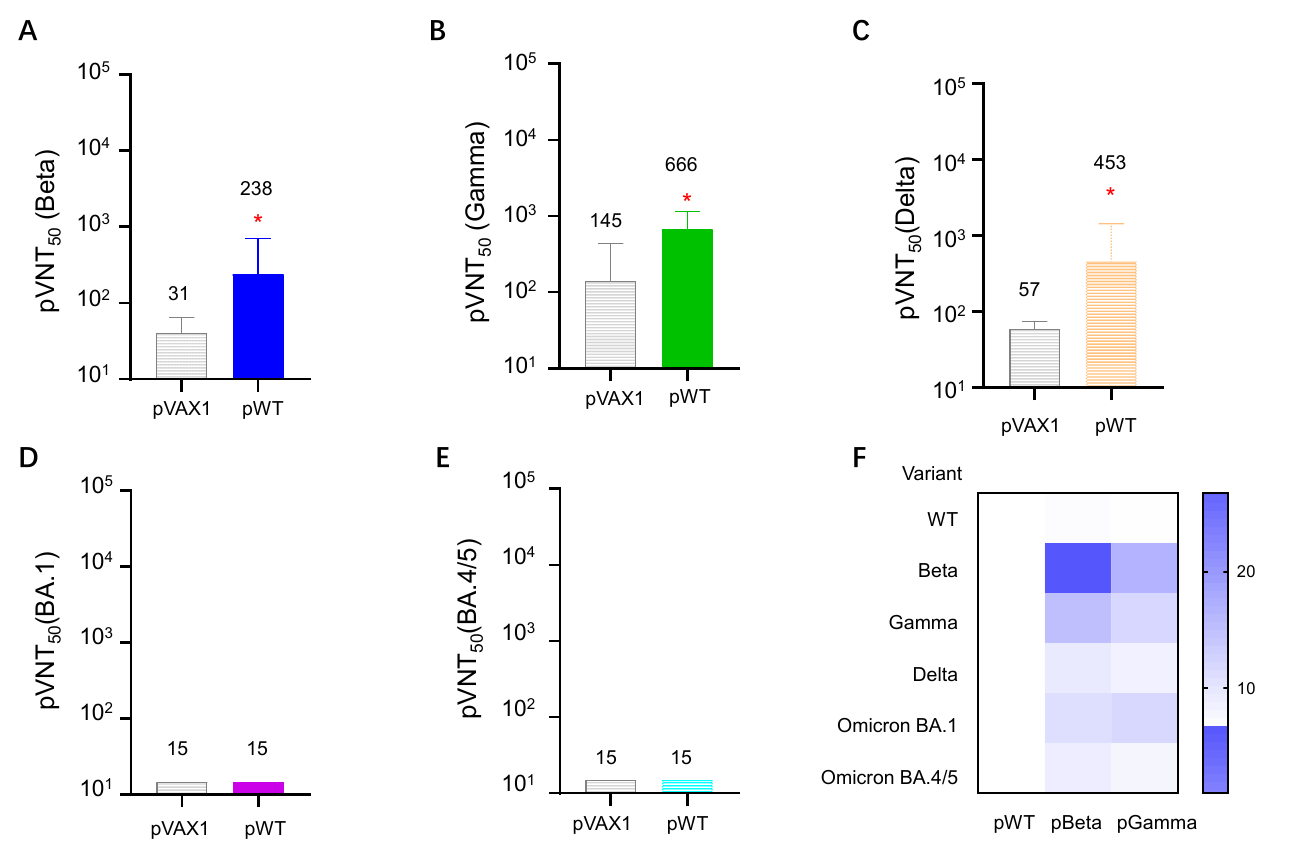
Figure 7. Cross-reactive neutralizing antibodies in mouse sera were detected by pseudo-virus neutralization on day 21. Sera from pWT-immunized mice were three-fold serially diluted starting at 1:30. Neutralization titers were calculated using GraphPad Prism 9.0 and defined as the reciprocal serum dilution at which RLU was reduced by 50% relative to virus control, and expressed as geometric mean ± SD. ( A ) Serum pVNT 50 to SARS-CoV-2 Beta variant, ( B ) serum pVNT 50 to SARS-CoV-2 variant Gamma, ( C ) serum pVNT 50 to SARS-CoV-2 variant Delta, ( D ) serum pVNT 50 to SARS-CoV-2 variant Omicron BA.1, ( E ) serum pVNT 50 to SARS-CoV-2 variant Omicron BA.4/5, ( F ) heatmap of relative neutralizing antibody elicited by pWT, pBeta, and pGamma. pVNT 50 of each virus variant elicited by pWT was denoted as 1.00. * denotes a significant difference compared with pVAX1 ( p < 0.05).